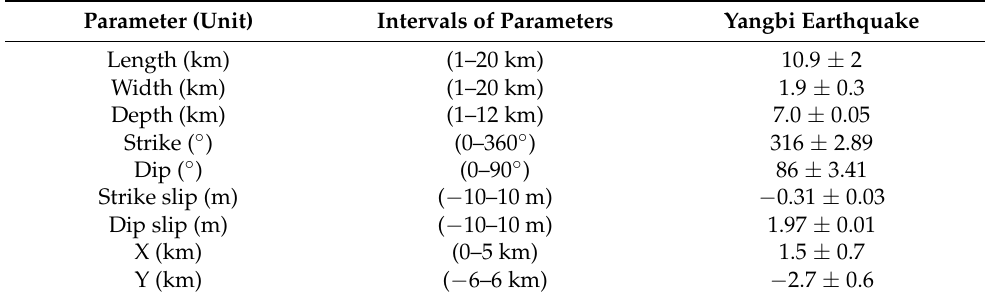
Table 2. The inverted fault length, width, strike angle, and dip provide parameters for the distributed slip model. Table 2. GBIS inversion of the Yangbi earthquake parameters and their standard deviations.